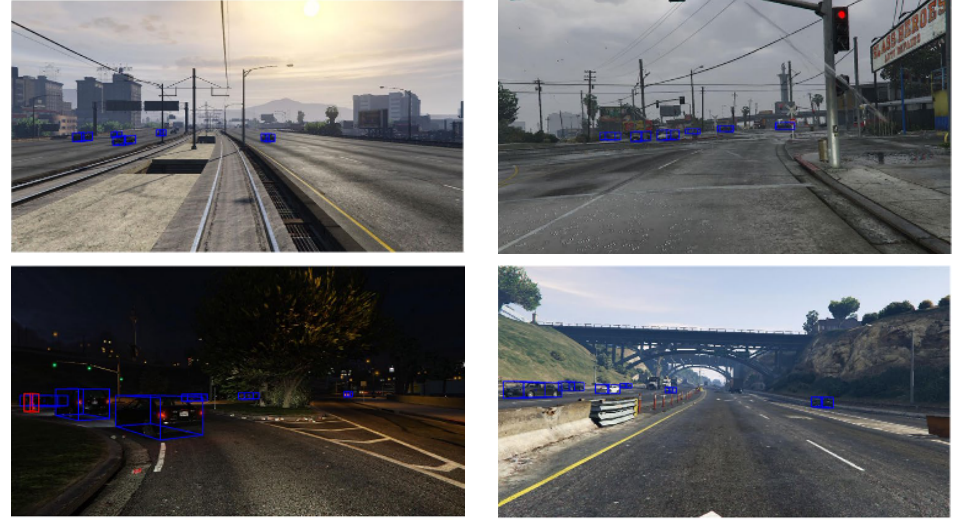
Figure 2. Some examples of our virtual multimodal road and railway GTAV dataset. Images include 3D bounding box ground truths. Top left : clear weather railway, top right : rainy weather road, bottom left : night scene, and bottom right : clear weather conditions. The ground truths shown are for the same classes as the KITTI dataset’s classes: Car (blue bounding boxes), Person, and Cycle (red bounding boxes)